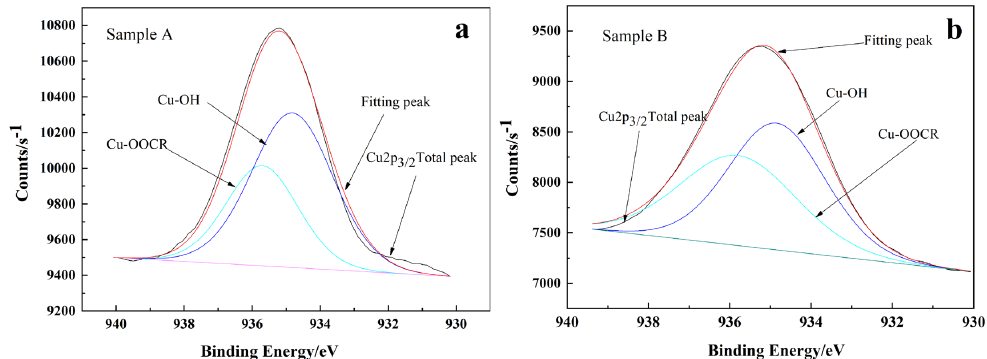
Figure 11. Peak-splitting fitting diagram of Cu2p 3/2 on the muscovite surface. ( a ), without electrochemical pretreatment; ( b ), electrochemical pretreatment.